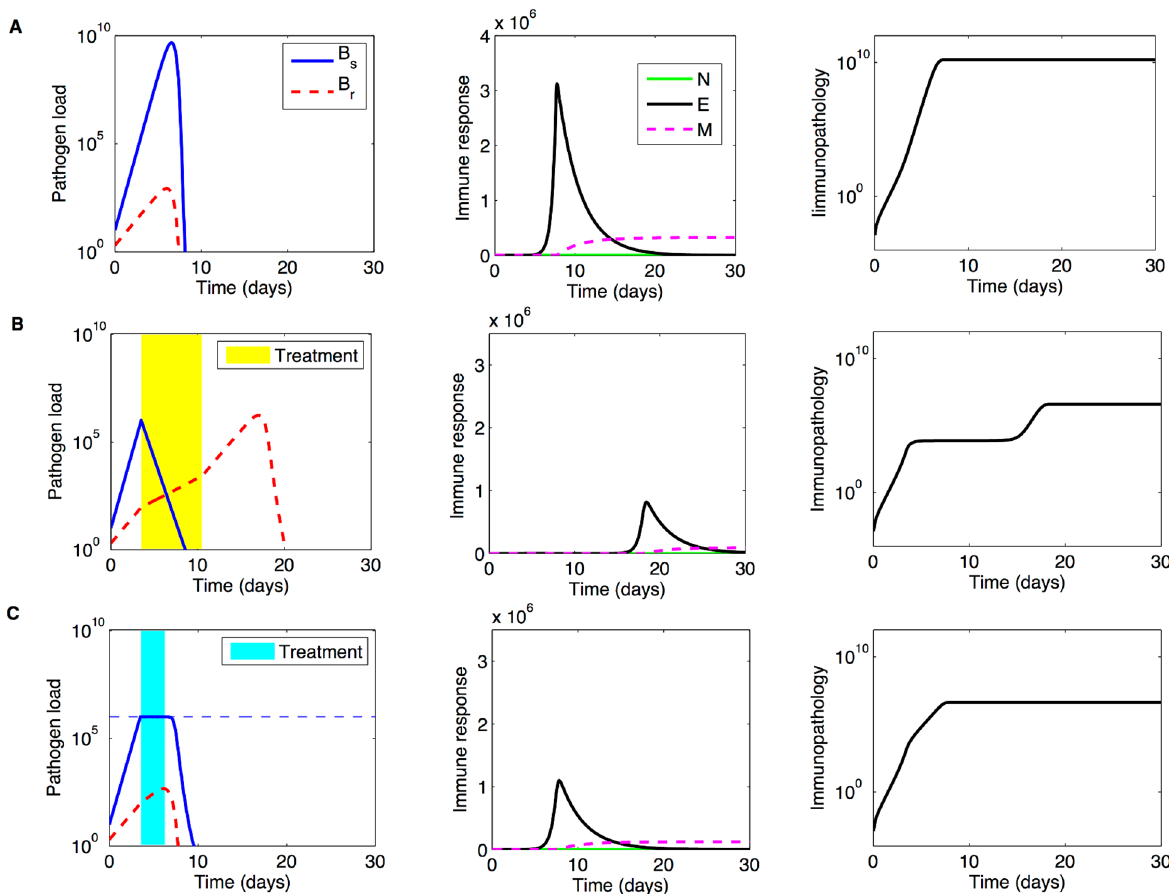
Fig 1. Illustration of model dynamics. A) Untreated infection. B) Classical treatment with: A m = 6, τ 1 = 3.5, τ 2 = 7. C) Adaptive treatment with parameters Ω = 10 6 , A m = 6. Other parameters as in Table 1. The resulting duration of adaptive treatment is 2.7 days. From the coupling to pathogen load, the effective rate of antibiotic uptake in adaptive treatment within such interval is 0.44, which implies a reduction in the effective dose from the prescribed A m = 6 to about 3, sufficient to restrict growth of the drug-sensitive sub-population. The treatment onset τ 1 = 3.5 days corresponds to Ω = 10 6 (adaptive regime), where Ω > k .